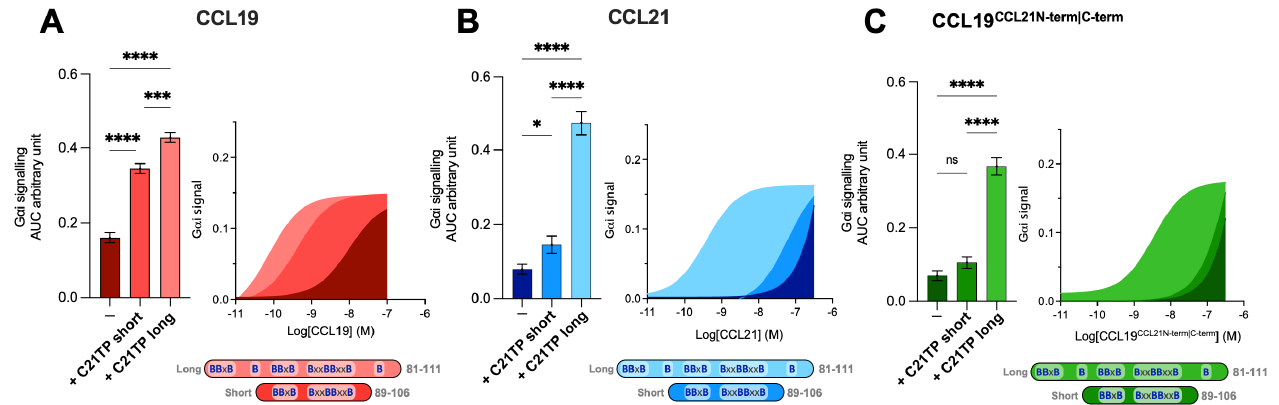
Figure 3. Long but not short C21TPs boost CCL19 CCL21N-term|C-term potency in G α i signaling. Areas under the curve (AUCs, arbitrary units) of cAMP signaling are shown as bar graphs and AUC curves. The length and location of BBx(x)B motifs in the short and long C21TPs are shown as graphical bars. The effect of short (89–106) and long (81–111) C21TPs on G α i signaling in response to ( A ) CCL19, ( B ) CCL21, and ( C ) CCL19 CCL21N-term|C-term was measured using BRET-based assays. C21TPs were added for a final concentration of 10 µ M. Statistical significances were determined using one-way ANOVA with Tukey’s multiple comparisons test ( n = 3). * p < 0.05, *** p < 0.001, **** p < 0.0001, ns non significant.